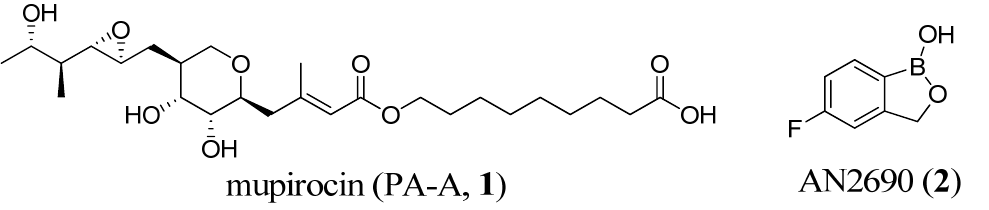
Figure 1. Structures of mupirocin and